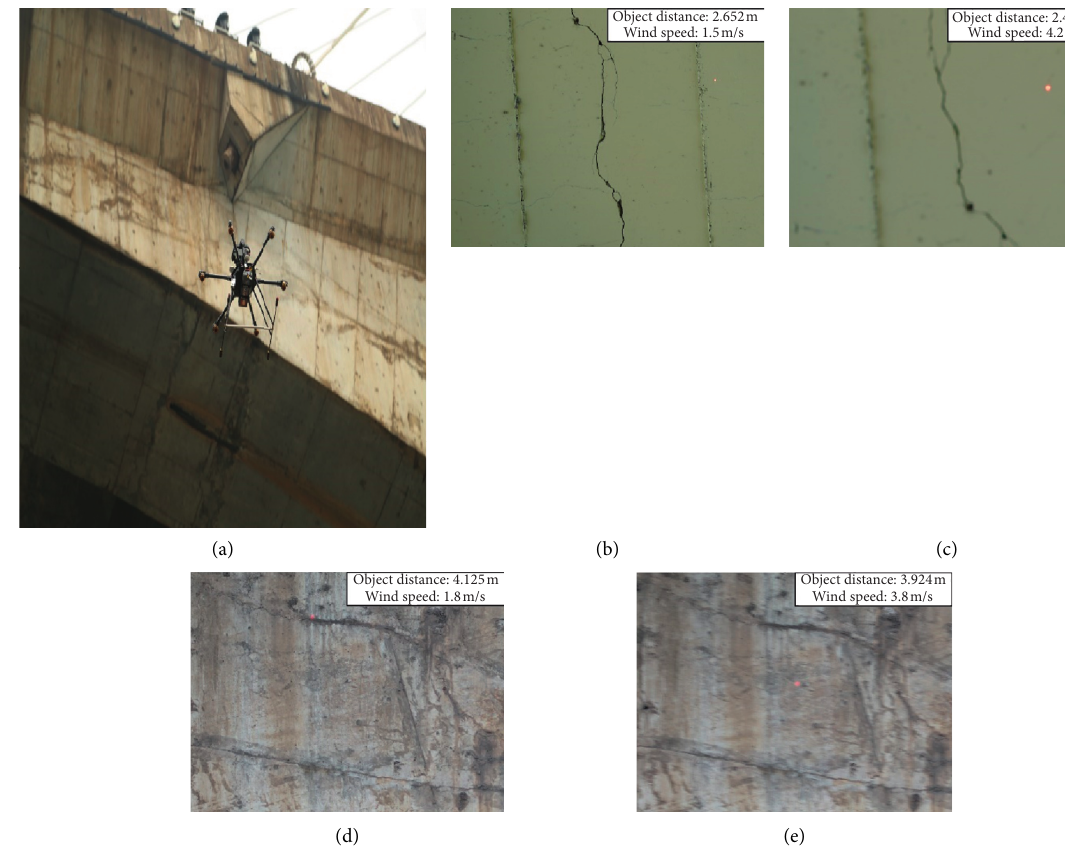
Figure 1: The bridge inspection process and images based on UAV, (a) UAV in bridge inspection state, (b) clear image of bridge crack, (c) unclear image of bridge crack, (d) clear image of bridge defect, and (e) unclear image of bridge